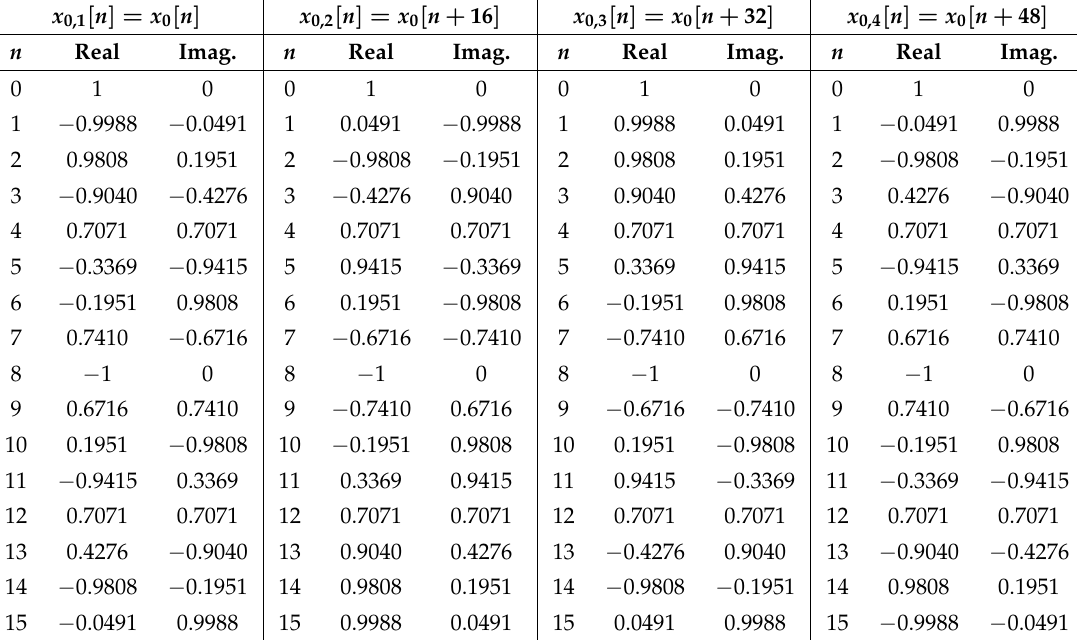
Table 1. Discrete-time basic chirp samples by segments of x 0 [ n ] for SF =